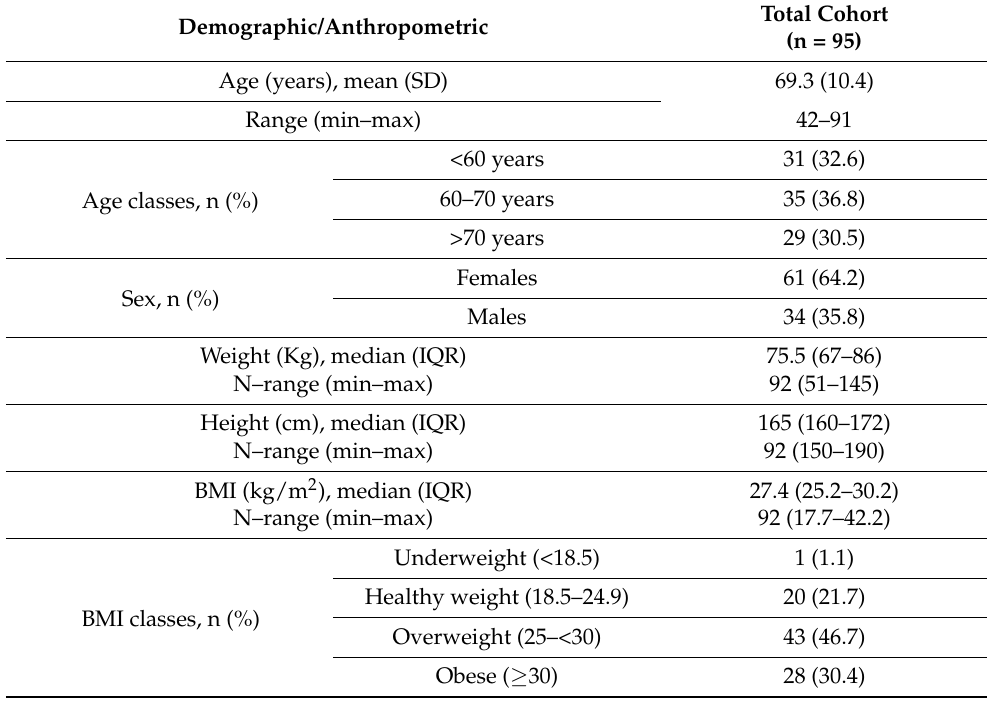
Table 1. Demographics of the studied population. BMI: body mass index.